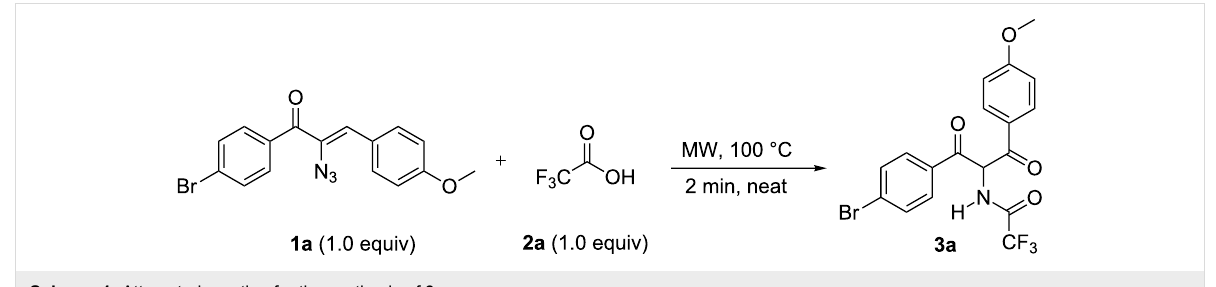
In this article, we intend to demonstrate the reactivity of 2 H -azirine A1 towards carboxylic acids [28]. α -Azidochal- cones have been chosen to generate 2 H -azirines via vinyl nitrene intermediates. α -Azidochalcones can be synthesized from the corresponding benzylidene acetophenones in two steps following a literature procedure